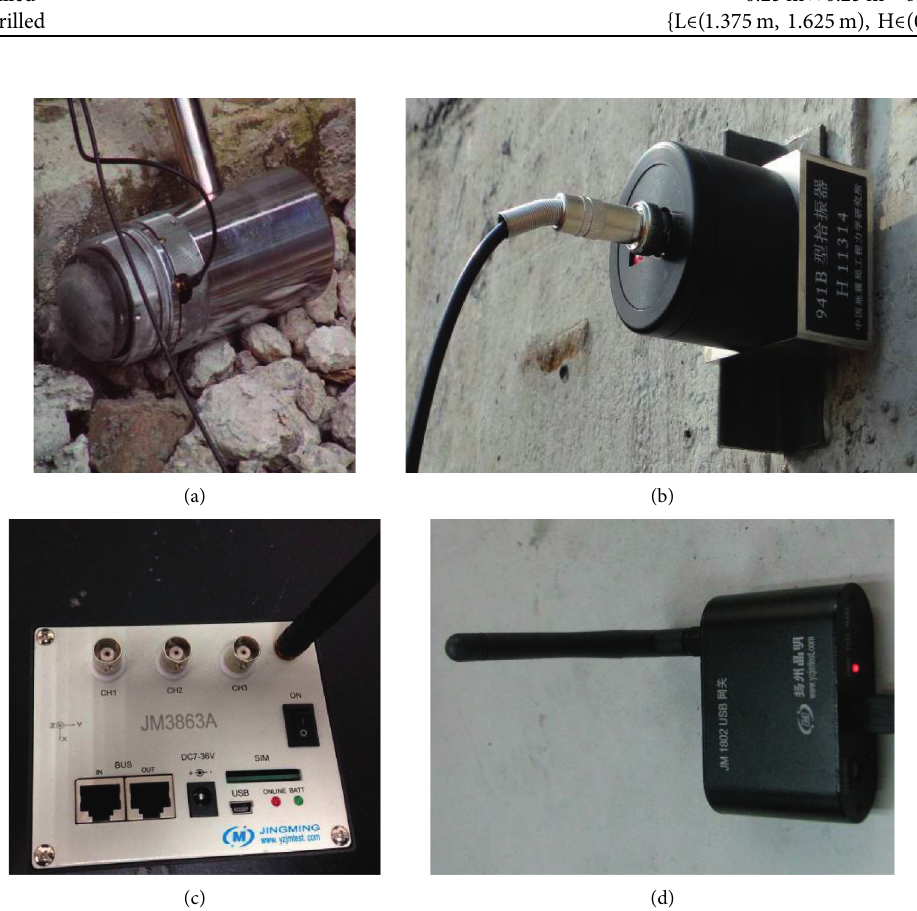
Figure 3: Exciting equipment, sensors, signal collecting system, and signal transmission system of vibration tests. (a) DFC-2 exciting hammer. (b) 941B sensor. (c) JM3863A vibration test system. (d) JM1802 wireless gateway.